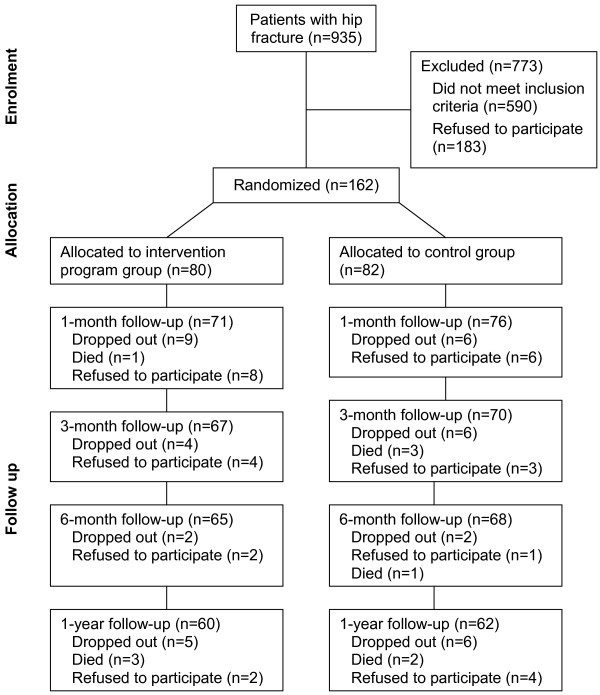
Study flow diagram. Sample recruitment process.